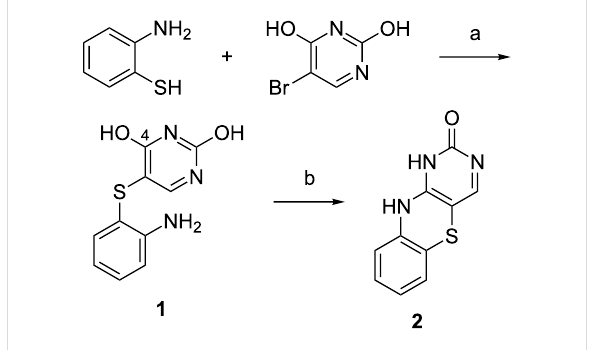
acceptor molecule could potentially also be used in base–base FRET in the